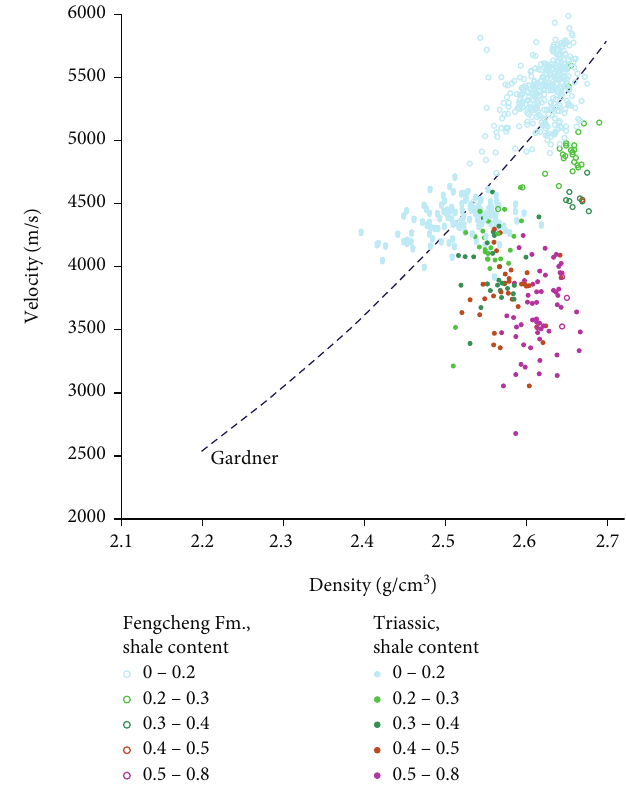
Figure 8: Relationship between density and velocity of the Triassic strata and Fengcheng Formation in the Mahu